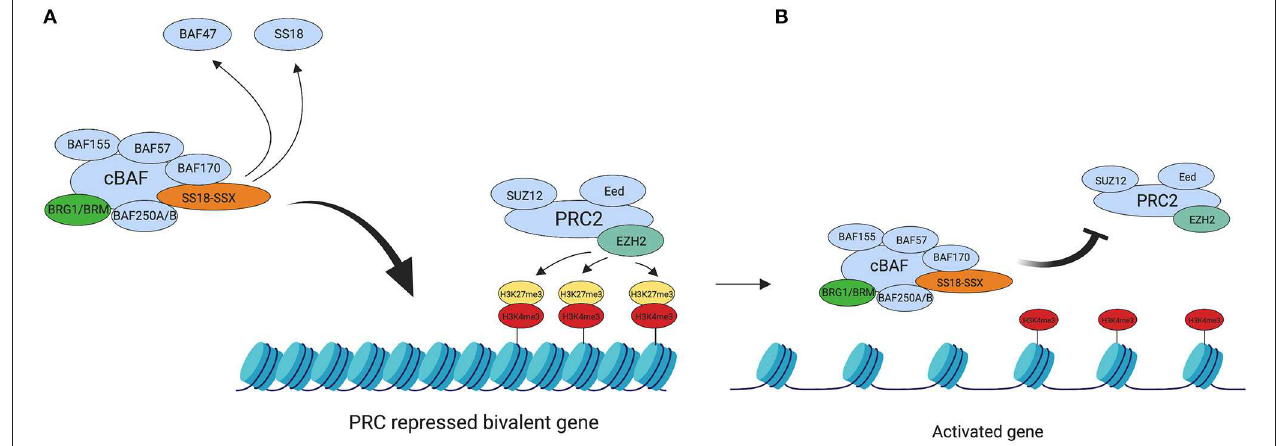
FIGURE 1 | BAF complex retargeting in SS. (A) The oncogenic BAF complex, including one of the SS18-SSX fusion proteins is retargeted to PRC2 repressed domains. SS18-SSX inclusion in the BAF complex leads to the eviction of both SS18 and BAF47 from the complex. PRC2 mediates its transcriptional silencing activity via the catalytic subunit EZH2. EZH2 catalyses the tri-methylation of H3K27, which leads to chromatin compaction. (B) The oncogenic BAF complex evicts the PRC2 complex, thus repressing its activity and activating the previously bivalent promoter. This leads to an abnormal gene expression profile across the genome due to a widespread epigenetic rewiring and drives tumourigenesis. Created with